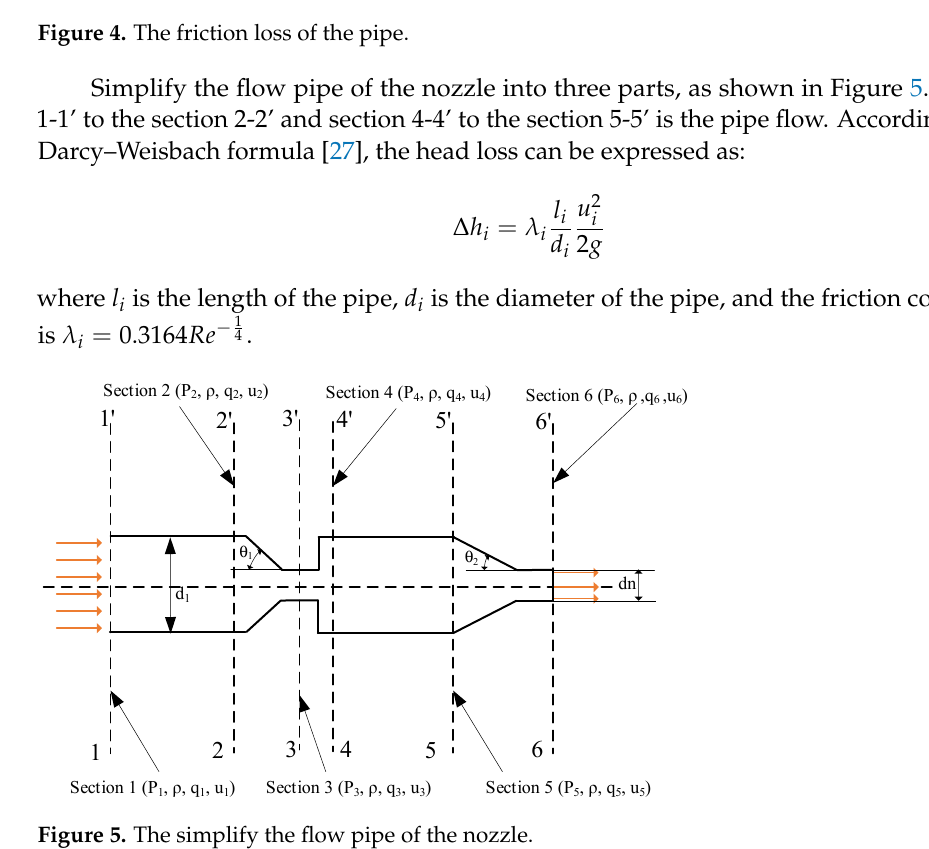
r 2 θ 1 Figure 6. Flow in the convergent pipe The other part is the flow at cross-section 3-3’ to 4-4’, where the cross-sectional area suddenly expands from 𝐴 (cid:2870) to 𝐴 (cid:2871) . The fluid enters the larger diameter pipe in the form of a jet, which generates pressure loss due to the surrounding fluid being wrapped to form a vortex, as shown in Figure 7. The head loss ∆ℎ (cid:2871)(cid:2872) of the sudden expansion of the pipe is: ∆ℎ (cid:2871)(cid:2872) = 𝜉 (cid:2871)(cid:2872) 𝑢 (cid:2870)(cid:2870) 2𝑔